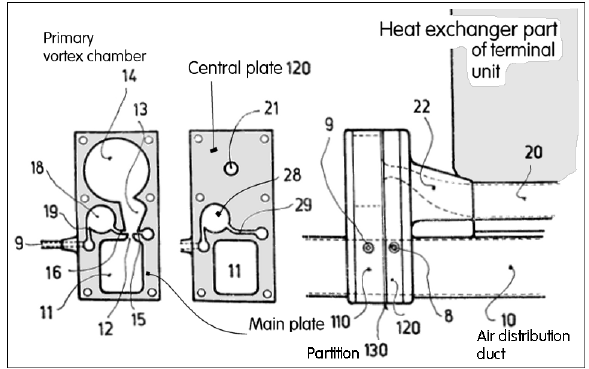
Fig. 14. Fluidic pulse-width controller of the oscillating-flow induction terminal unit shown in Fig. 13. Principle of operation is recognisable from the circuit diagram in